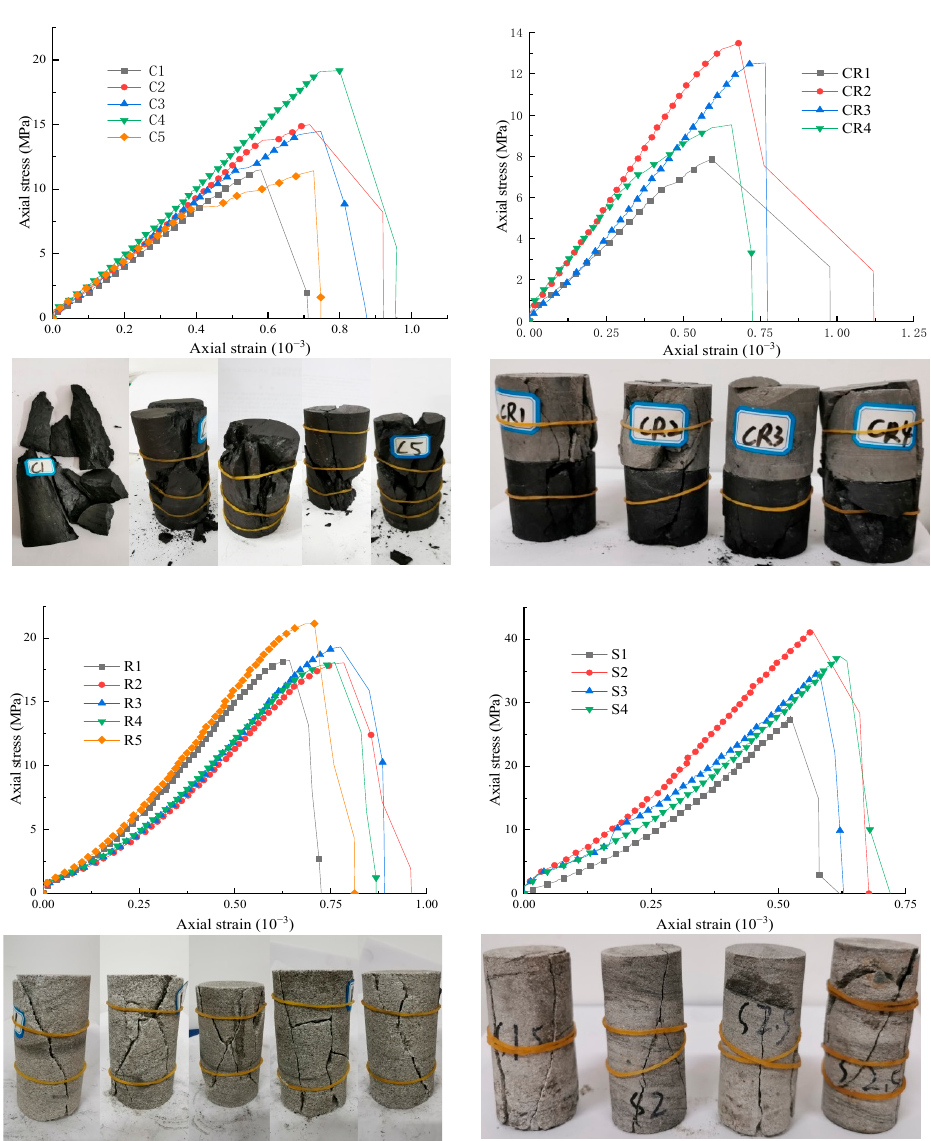
Figure 5. Stress–strain curve and failure mode of rock uniaxial compression experiment.